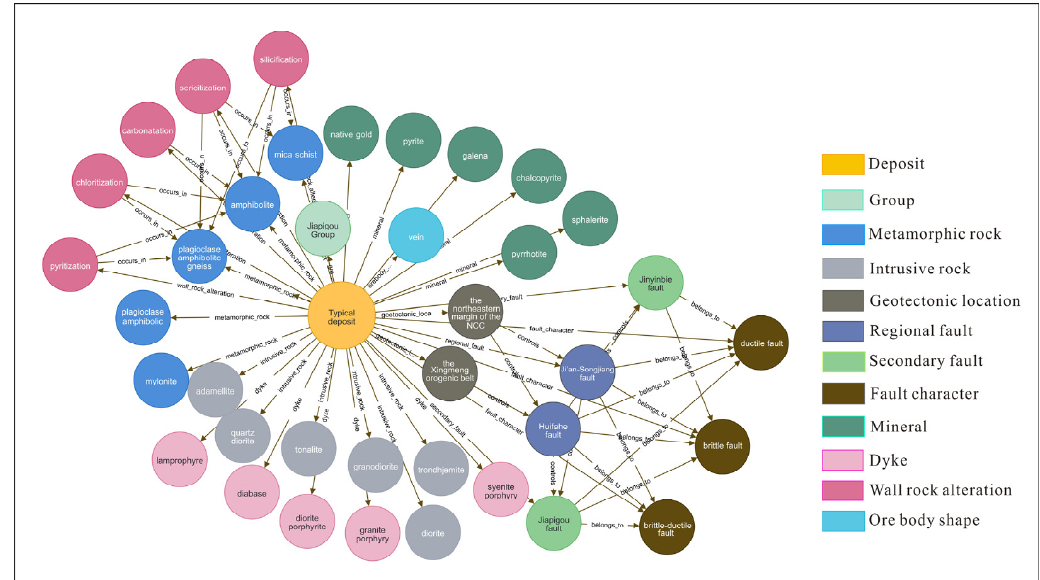
28 of 33 Table 12. Regional prospecting criteria of the JGMB. Regional Prospecting Criteria Country rocks TTGs, amphibolite, gneiss, Mesozoic granite. Wall rock alterations